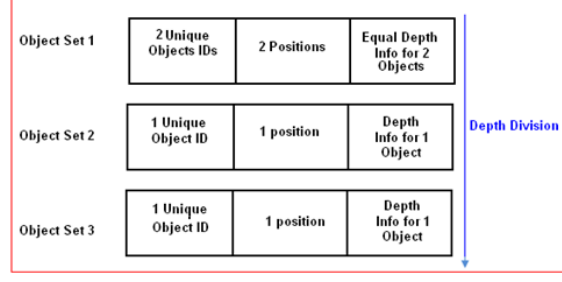
Figure 13. A typical object set